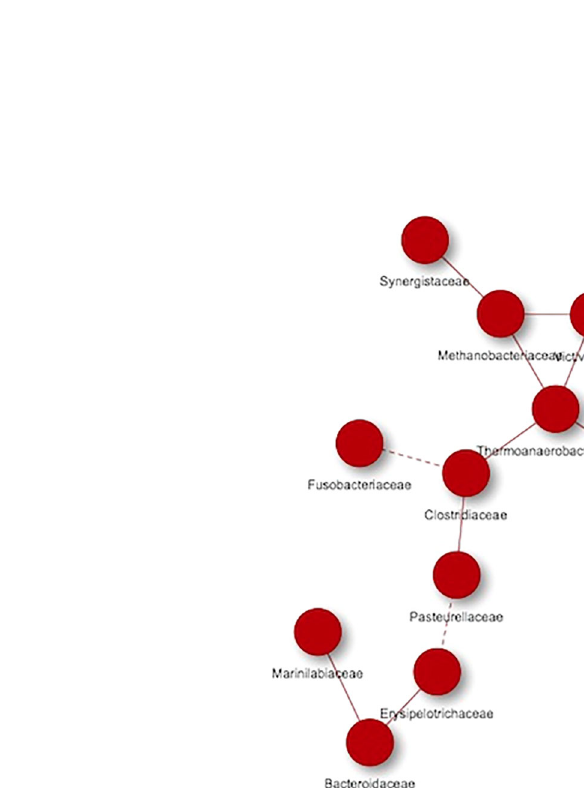
FIGURE 6 Co-occurrence networks of microorganisms present in hypercholesterolemic individuals. Continuous lines (edges) refer to co-occurrences that occur between microorganisms with a higher frequency than expected, while dashed lines correspond to interactions with less frequency than expected. P-value